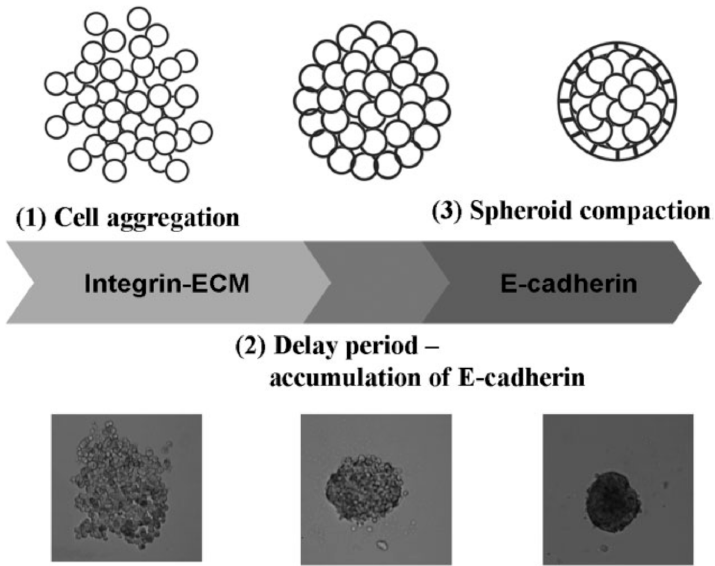
Figure 3. The processes of the spheroid formation: ( 1 ) formation of loose cell aggregates via integrin-ECM binding; ( 2 ) a delay period for cadherin expression and accumulation; ( 3 ) formation of compact spheroids through hemophilic cadherin-cadherin interactions, courtesy of